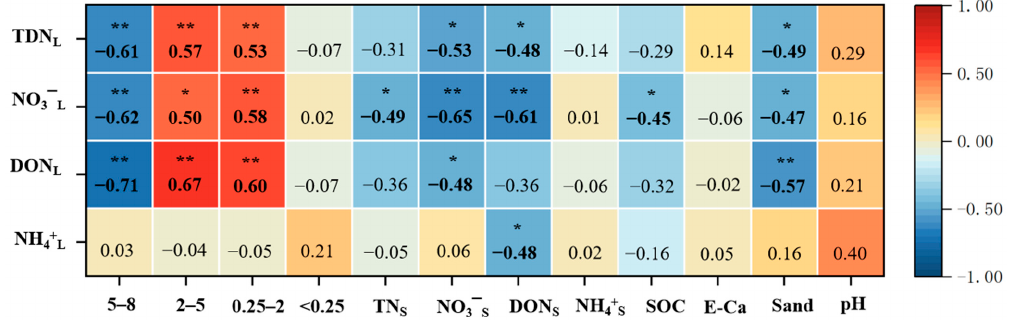
Figure 3. Amount ( a ) and rate ( b ) of nitrogen forms (including NO 3 ¯ , DON, and NH 4+ ) in leachate under tillage disturbance after 1 year. T0, no tillage; T1, semiannual tillage; T2, tillage every four months; T3, bimonthly tillage; T4, monthly tillage. Different letters indicate significant differences among treatments (one-way ANOVA, p < 0.05). Bars represent mean ± standard error ( n = 4).